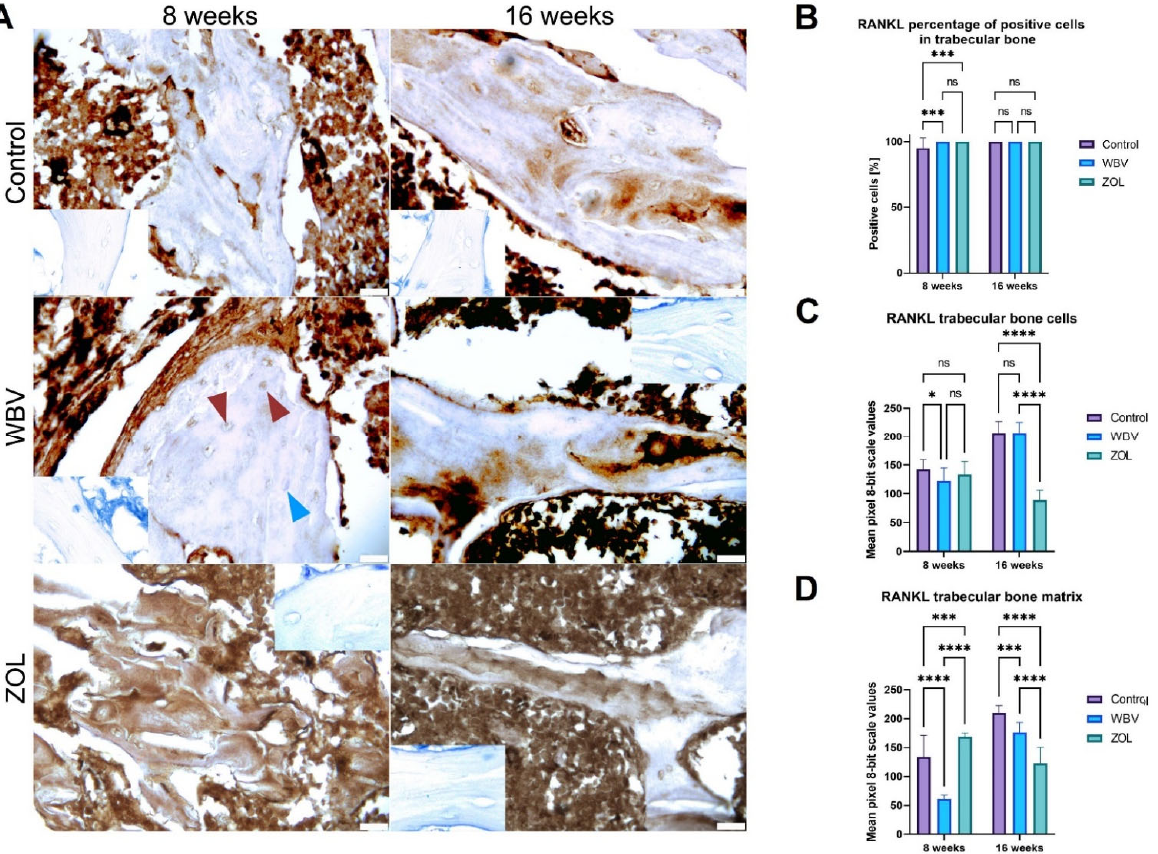
Figure 10. The immunohistochemical reaction for receptor activator for nuclear factor kappa-B ligand (RANKL) in the trabeculae of distal metaphysis of femora of rats subjected to obesity and immobility: ( A ) Representative images of the immunohistochemical reactions for RANKL. Brown and blue arrowheads indicate examples of positive and negative reaction cells, respectively. Insets show control immunohistochemical staining without primary antibody. All scale bars represent 50 µ m; bar graphs show the ( B ) the percentage of RANKL-positive cells and the intensity of immunoexpression of RANKL ( C ) in trabecular bone cells, and ( D ) trabecular bone matrix measured by the 8-bit grayscale pixel brightness value (the higher the pixel value, the higher the intensity of the immunohistochemical reaction). Data are mean values ± SD from n = 6 rats. Control—the control group included rats subjected to obesity and immobility not treated with WBV or ZOL; WBV—the WBV group included rats subjected to obesity and immobility with body vibration treatment (30 min, 5 days per week); ZOL—the ZOL group included rats subjected to obesity and immobility and injected intramuscularly with zoledronic acid at a dose of 0.025 mg/kg body weight every 4 weeks. Statistical significance: ns—not significant; * p < 0.05; *** p < 0.001; **** p < 0.0001 (Tukey’s HSD test or Kruskal–Wallis H